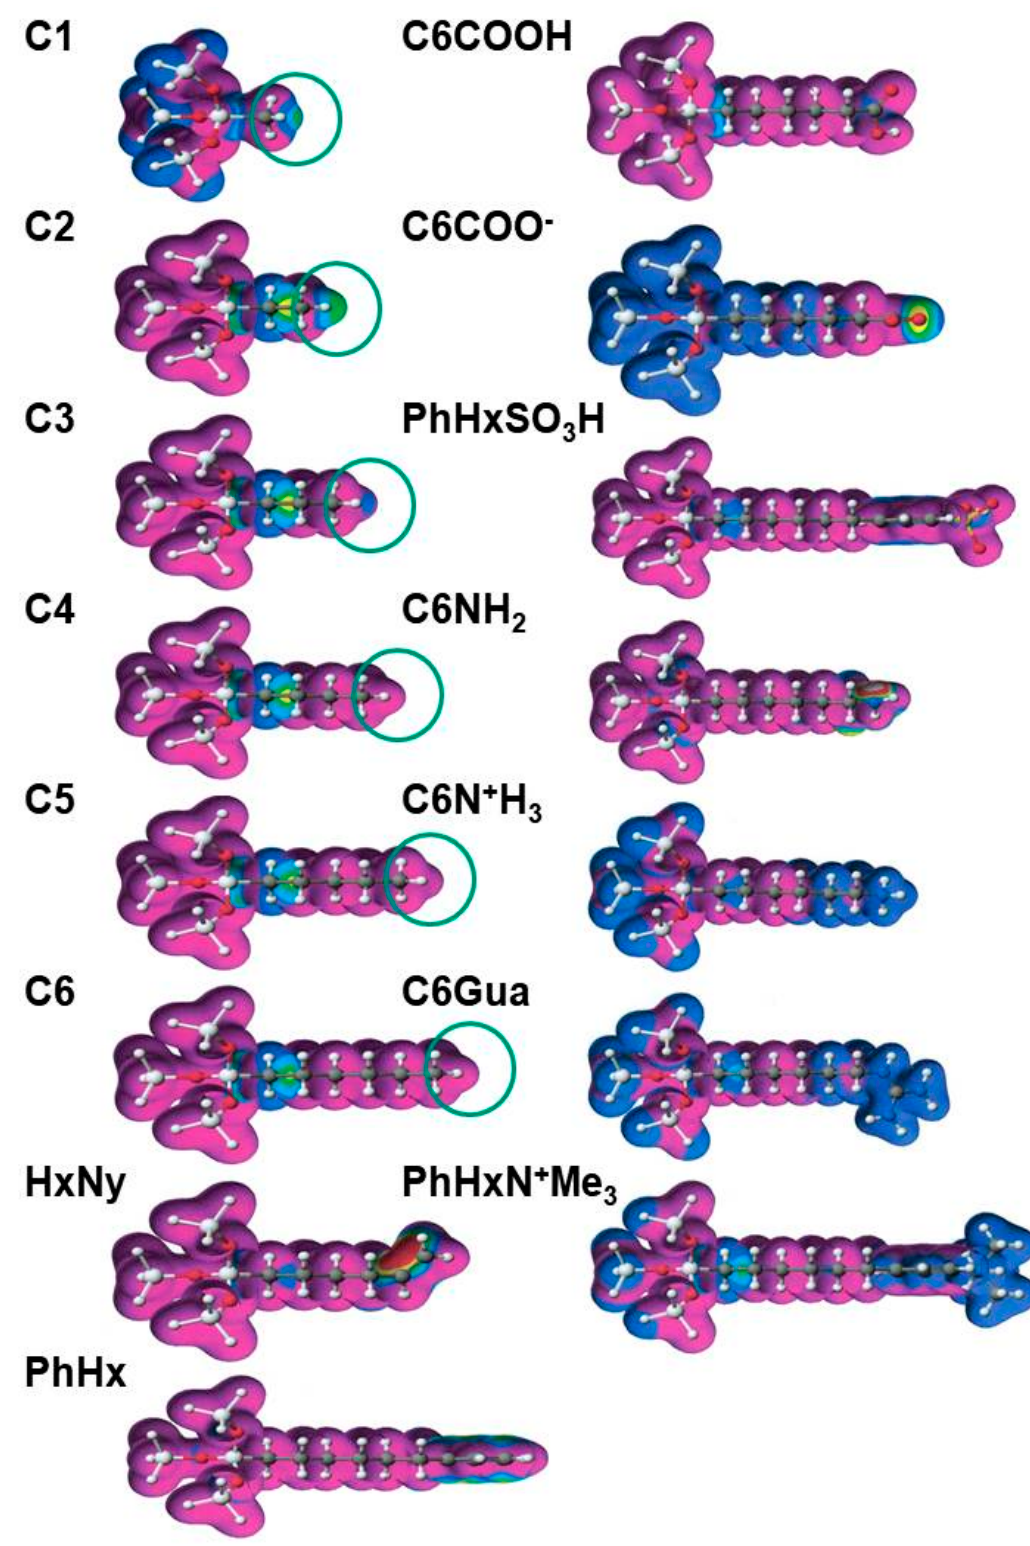
Figure 2. Electron density (electrophilic susceptibility) of model ligands. For an explain of the symbols see Figure 1. Electron density indicates from high to low (white > red > yellow > light green > light blue > blue > magenta > purple). Ionization changes the electron density from magenta to blue (see C6COOH and C6COO − ). Cationic and anionic indicate the opposite electron density (see C6N + H 3 , C6Gua, and PhHxN + Me 3 ).